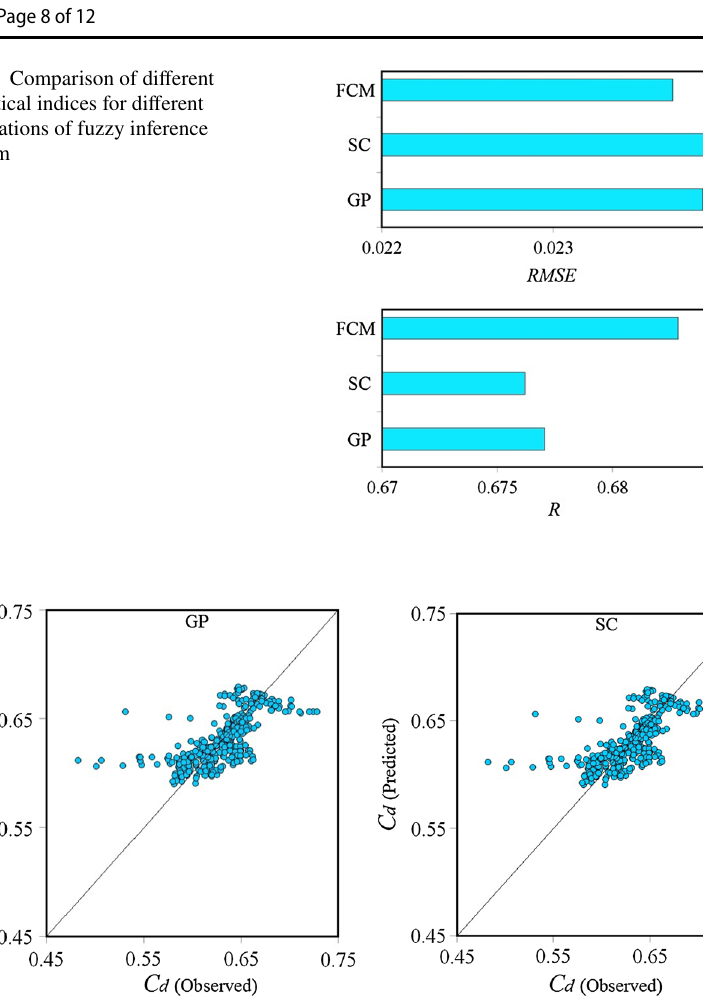
Fig. 7 Scatter plots for different generations of fuzzy inference system